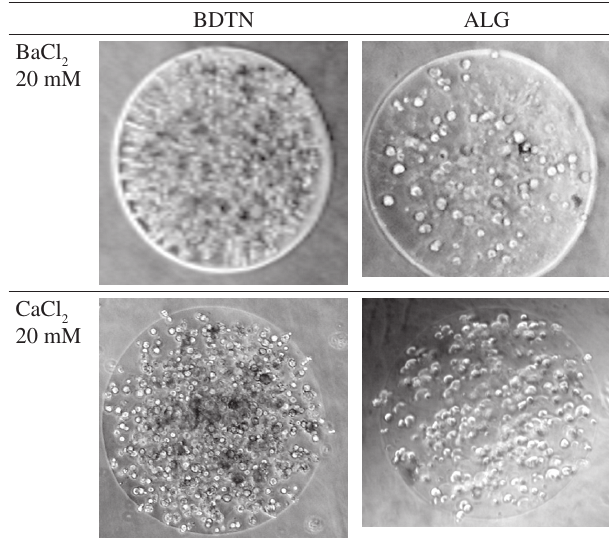
Figure 6. Photomicrography of RINm-5f cells encapsulated in BDTN- BaCl , BDTN-CaCl , ALG-BaCl and ALG-CaCl after 7 days of cultivation, 2 2 2 2 culturing as described in Material and Methods. BDTN – Biodritin ® , ALG –